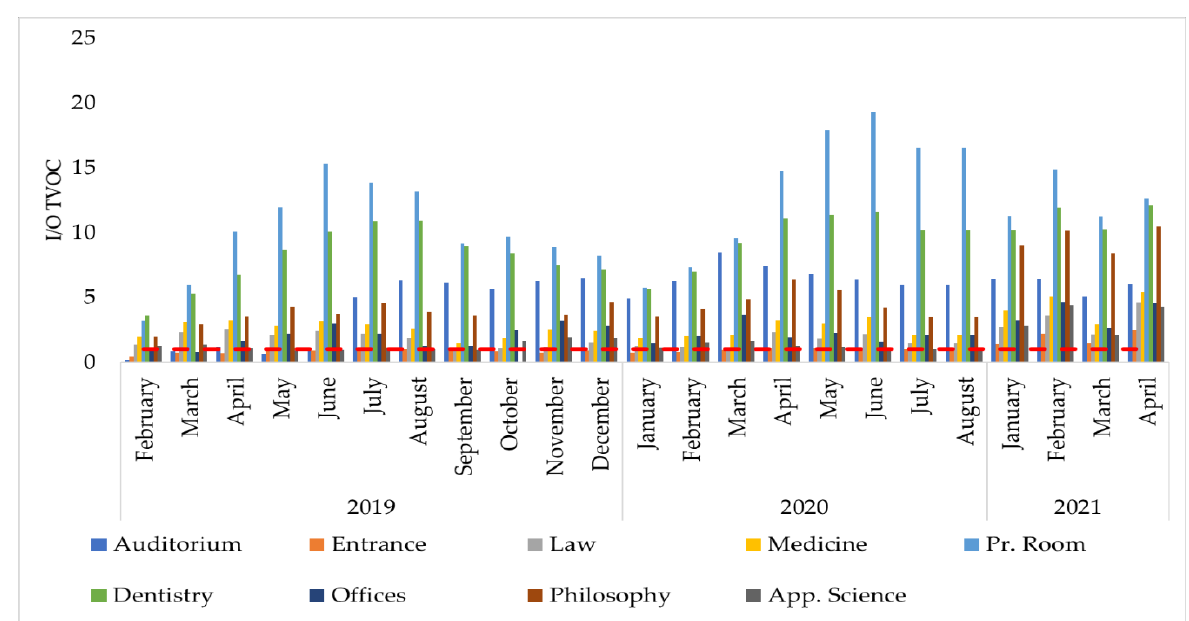
Figure 10. Indoor to outdoor (I/O) ratio of CO 2 levels within the museum during the entire experimental period.